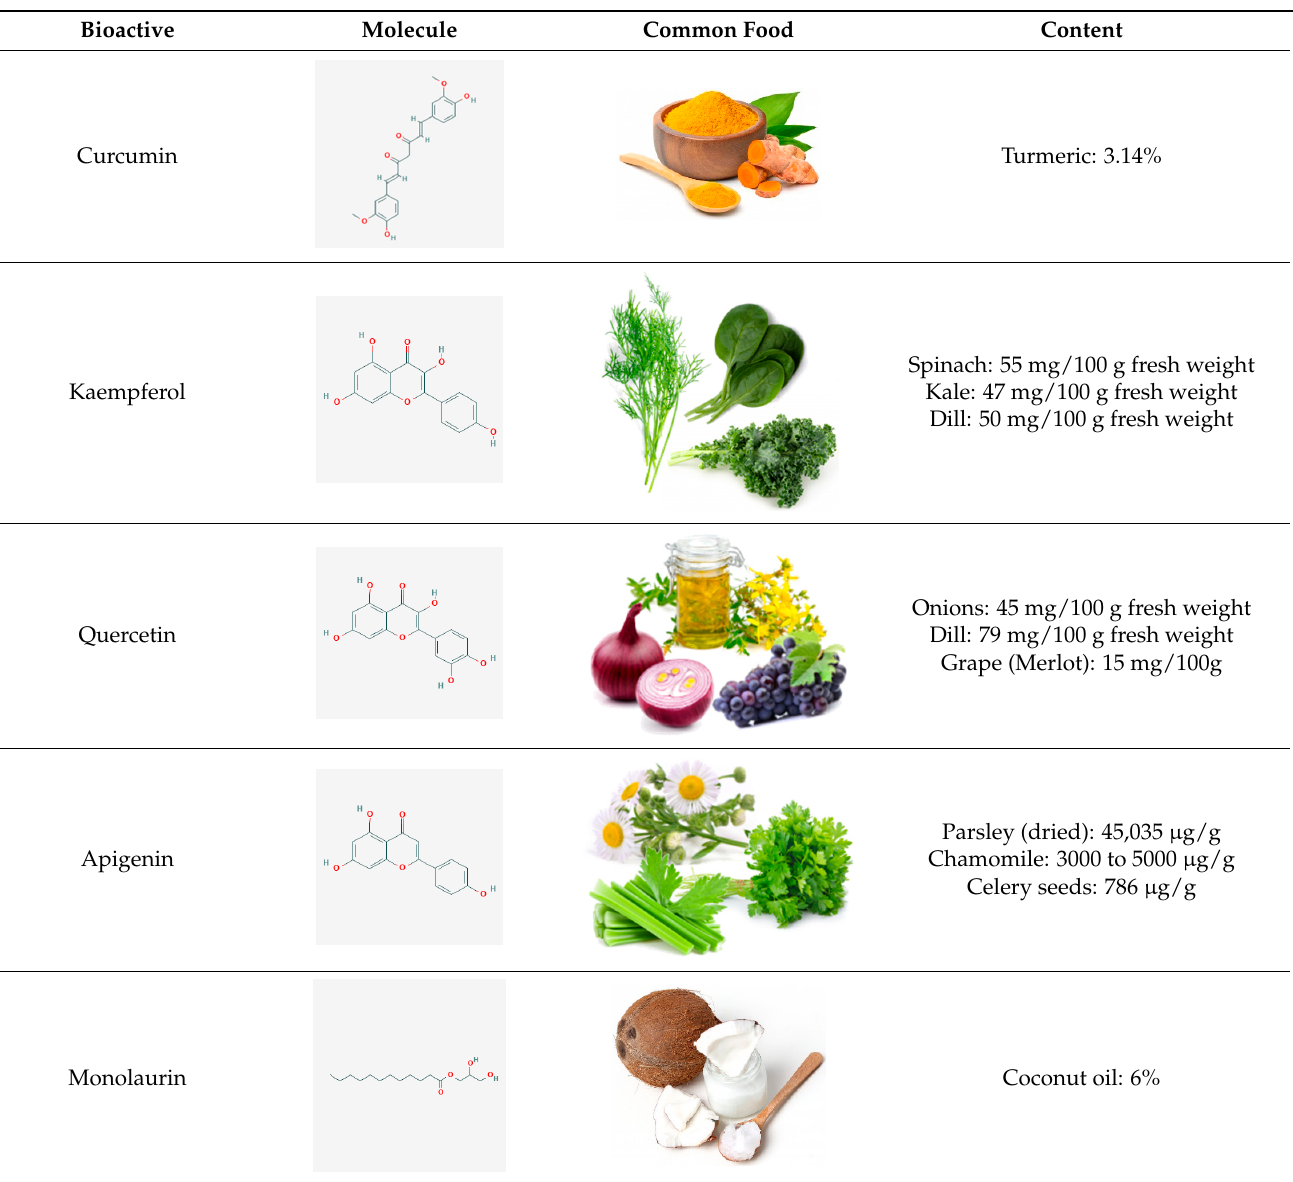
Table 2. Summary of the bioactive compounds selected and common foods and content.